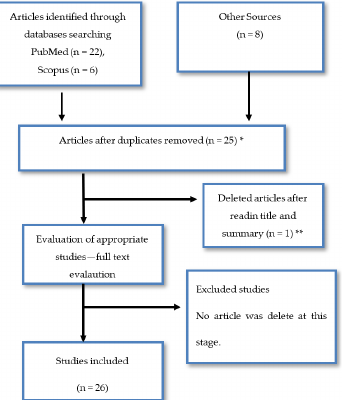
Figure 2. Flow diagram. Schematic representation of the searching procedure and the evaluation of the articles based on the inclusion and exclusion criteria. (* After duplicate removal, 2 papers were only found on Scopus, 4 articles were only from other sources and the rest only from Pubmed. ** The Hiyama et al. (1998) [81] paper was removed as a paper that does not study collagen, but is focused on type A fibrils of the mouse tectorial membrane.)